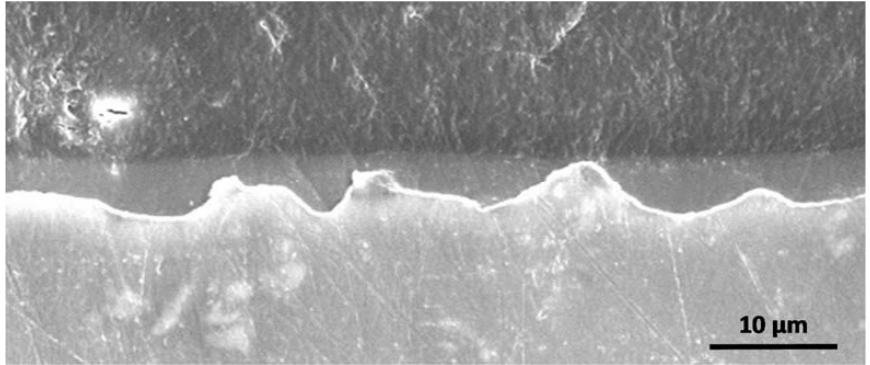
Figure. 15. SEM micrograph for coating obtained at withdrawal speed 300 mm min − 1 .